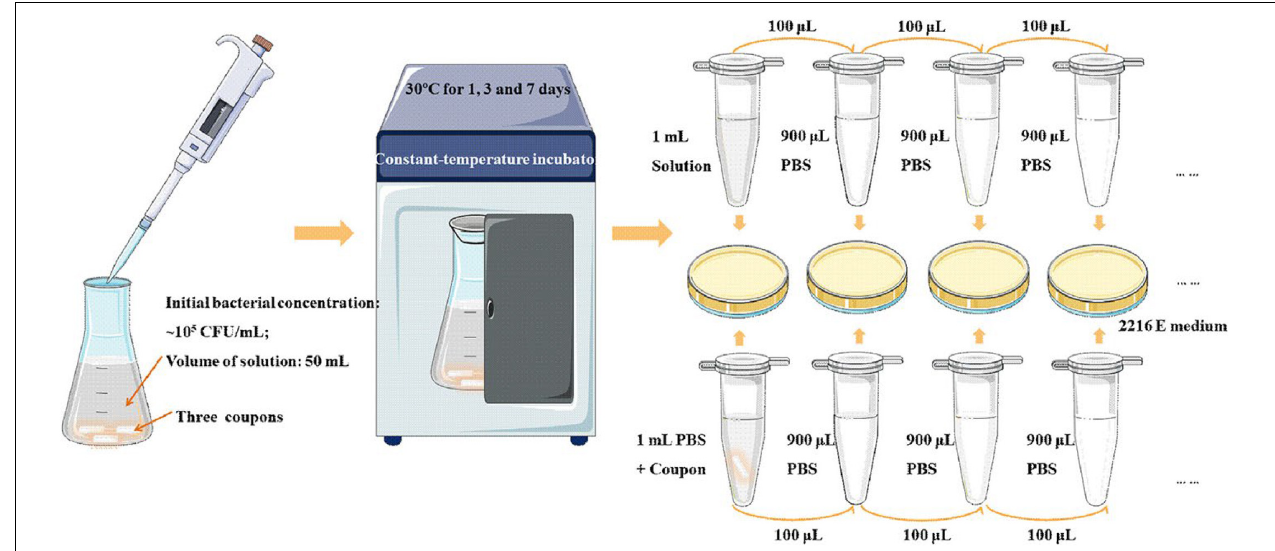
FIGURE 8 | Schematic diagram displaying the antibacterial testing experimental process (Zhou et al., 2020). Reproduced from Zhou et al. (2020) with